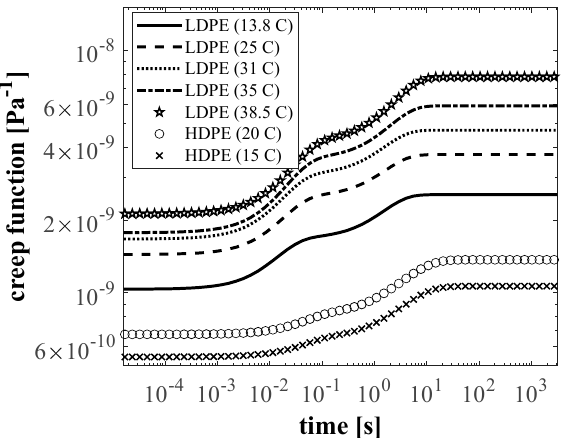
Figure 3. Creep functions for two different PE pipes.